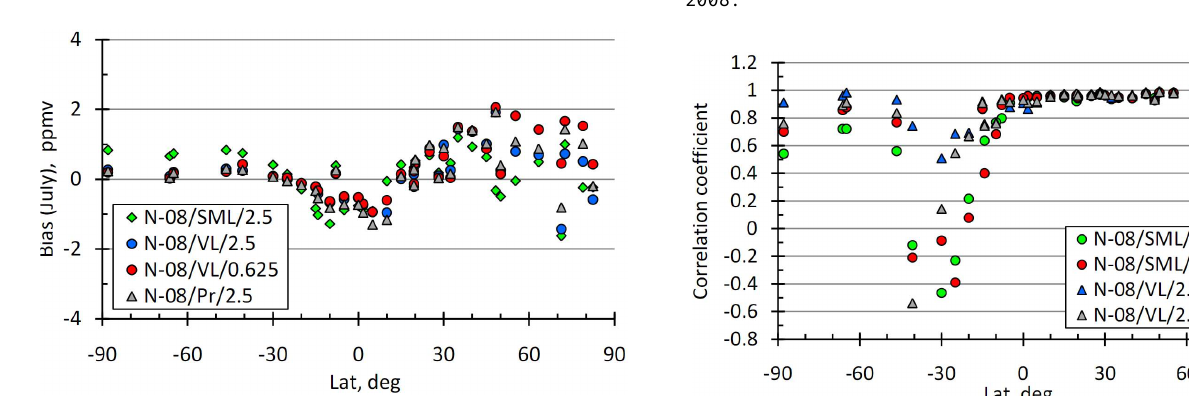
Fig. 9. Monthly averaged CO 2 bias (model – observations) for Jan- uary 2008 (ppmv).